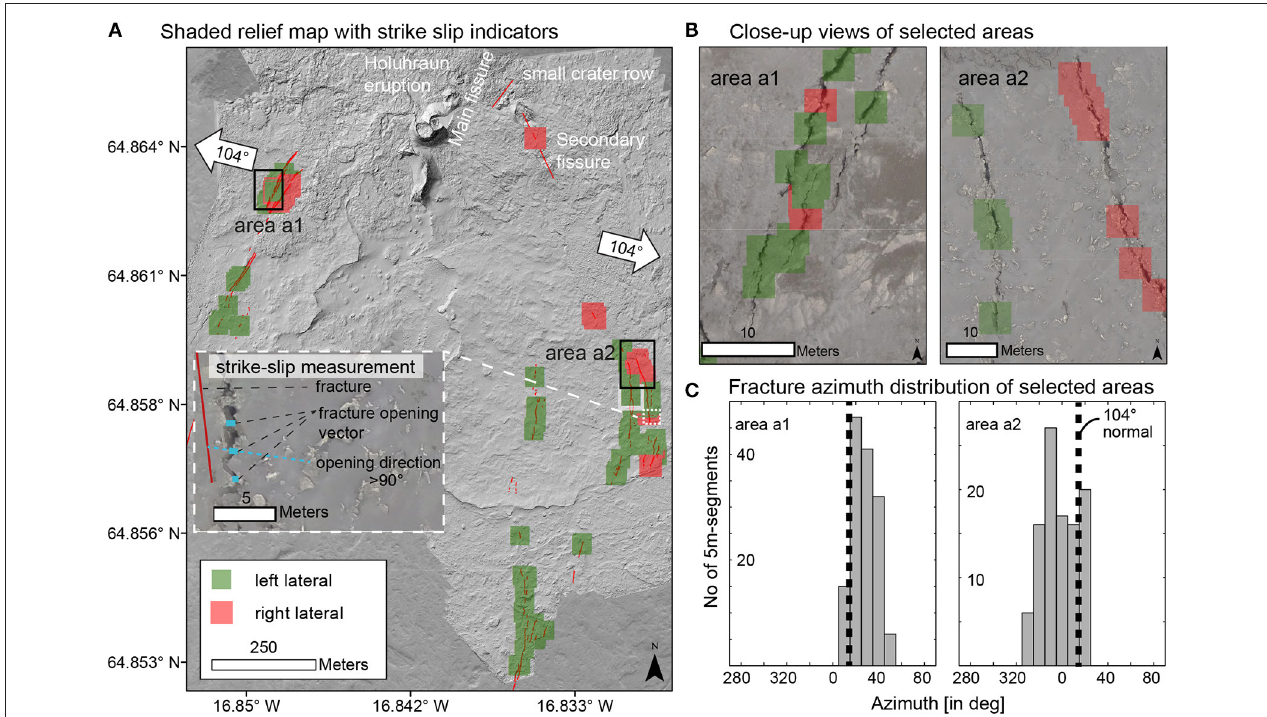
FIGURE 6 | Assessment of strike-slip components– (A) Strike-slip components measured at 143 positions, indicated by red and green boxes in areas a1 and a2 ( Figure 4B ), showing the dominance of left-lateral motion (green boxes). Right-lateral slip (red boxes) and tensile opening components (no color at fracture) can also be observed. Systematic analysis reveals the consistency of kinematics along distinct fracture traces as well as local complexities, such as opposite motions at adjacent fracture traces. The inset indicates how strike-slip was determined. (B) Close-up views of selected areas a1 and a2. Note that although both left-lateral and right-lateral components can be observed in our data close to this eruption site, the left-lateral transtensional mode is clearly dominant. (C) Histogram analysis and comparison of the strike directions of the two areas against the rift-normal direction; a uniform rifting of 104 ◦ is